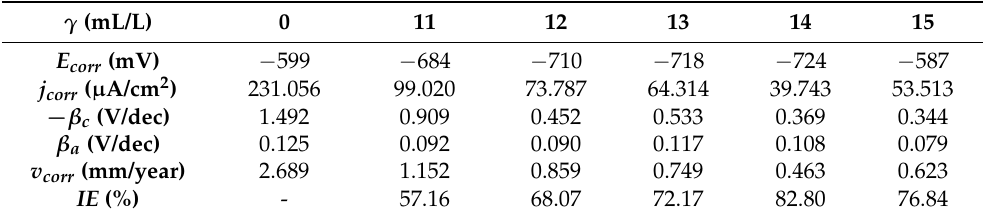
Table 4. Electrochemical parameters determined from polarization curves scanned on the carbon-steel sample in the simulated brine saturated with CO 2 with and without inhibitor in flow conditions (Data from